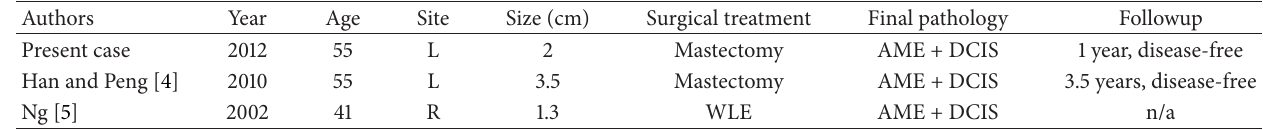
Table 1: Summary of cases of adenomyoepithelioma with ductal carcinoma in situ of the breast.